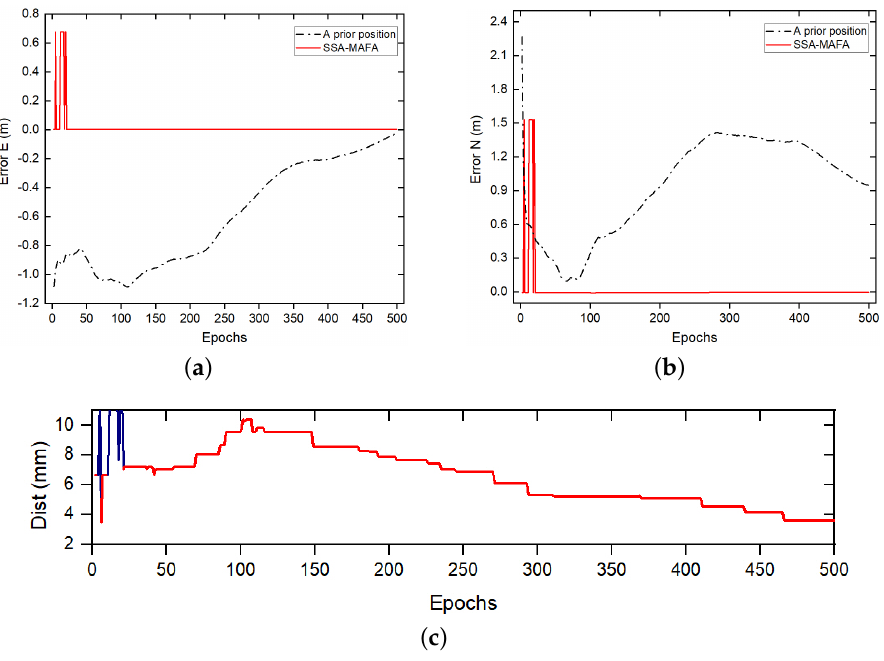
Figure 10. Error result of SSA-MAFA with z coordinate fixed to referenced value. ( a ) The error in East direction. ( b ) The error in North direction. ( c ) The error in East and North direction from epoch 1 to epoch (cid:113) + err 2 err 2 500, where Dist = , the blue line indicates the wrong solution. E N